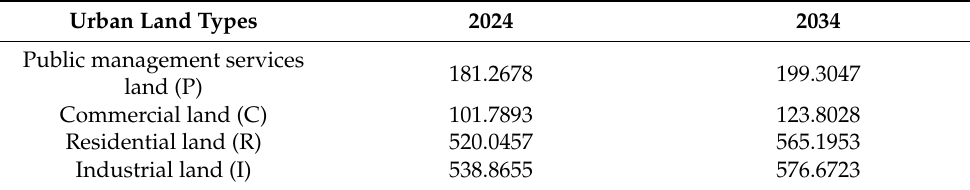
Table 4. Volume demand for each urban land expansion under future years.